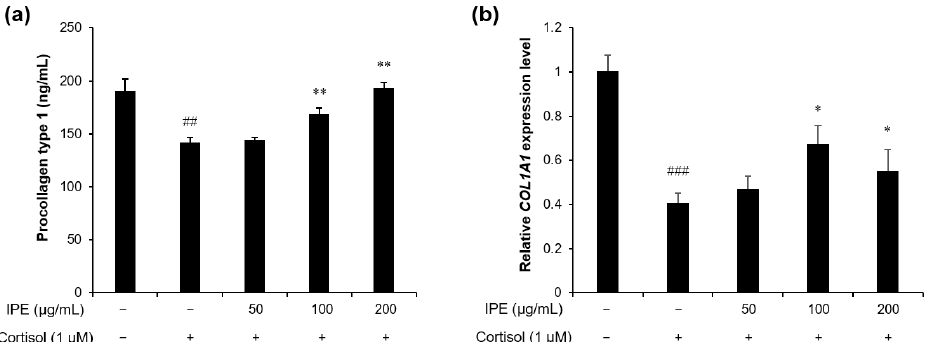
Figure 2. Effects of IPE on collagen type 1 synthesis in cortisol-exposed HDFs. The cells were pretreated with IPE (50, 100, and 200 µ g/mL) and, then, treated with cortisol (1 µ M) for 48 h. ( a ) Enzyme-linked immunosorbent assay of procollagen type 1 level in the culture supernatant of HDFs. ( b ) Real-time quantitative reverse-transcription polymerase chain reaction of relative COL1A1 expression levels. ## p < 0.01, ### p < 0.001 compared to the control that was not exposed to cortisol; * p < 0.05, ** p < 0.01, compared to the cortisol-exposed control.